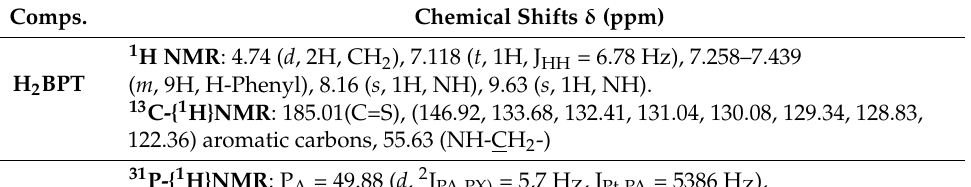
Table 3. 31 P-{ 1 H}, 13 C-{ 1 H} , and 1 H-NMR chemical shifts for the synthesized complexes ( 1 – 7 ) and the H 2 BPT